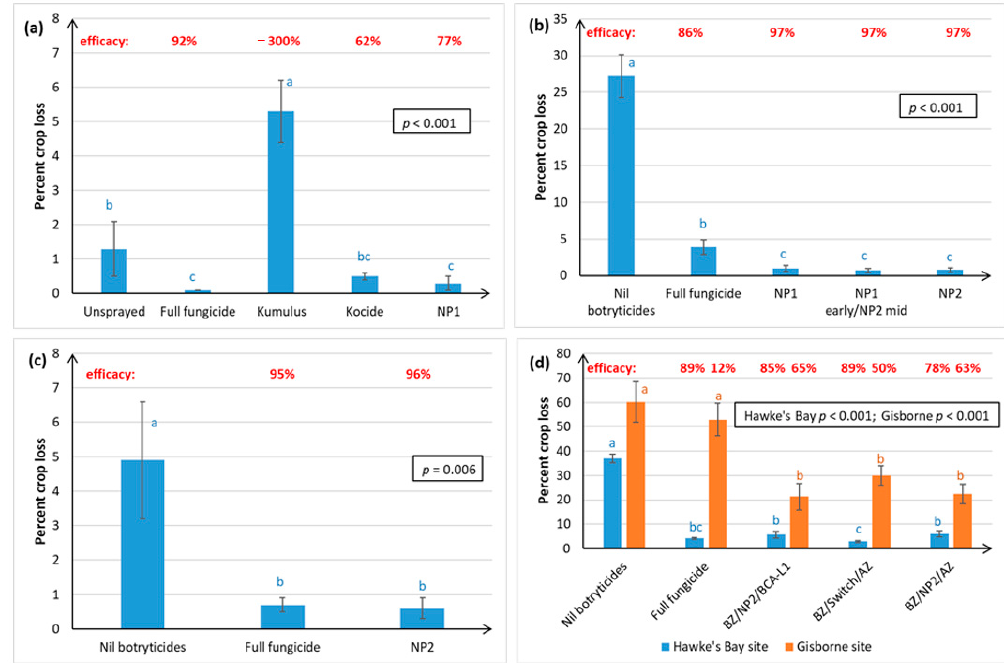
Figure 2. Percentage crop loss resulting from Botrytis bunch rot infections of Chardonnay grapes, as assessed at harvest in April, over four successive seasons. Crop loss was calculated as (%bunch severity × %bunch incidence)/100 for 50 randomly harvested bunches per plot. The efficacy calculation is outlined in Figure 1. Treatments are described in full in Tables S1 and S2, and briefly in Figure 1. In Season 1 only (Figure 2 a only), there was an unsprayed treatment, and the Kumulus ® DF (3 g/L), Kocide ® 2000 DF and NP1 (7 g/L) treatments were applied right throughout the growing season (from mid-November until mid-March) instead of just between post-bloom and post-bunch closure (Figure 2 b – d ). Each graph represents data from a separate season, with error bars indicating standard errors, boxed values showing probabilities obtained from ANOVA, and different letters indicating statistically significant differences from pairwise likelihood ratio tests, which are only presented when the ANOVA p ≤ 0.05. The concentration of the active ingredient in the NP formulation is indicated in parentheses for each specific experiment. ( a ) Season 1, Hawke’s Bay site, NP1 (7 g/L); ( b ) Season 2, Hawke’s Bay site, NP1 (7 g/L) and NP (15 g/L); ( c ) Season 3, Hawke’s Bay site, NP2 (5 g/L); ( d ) Season 4, Hawke’s Bay and Gisborne sites, NP2 (5 g/L).